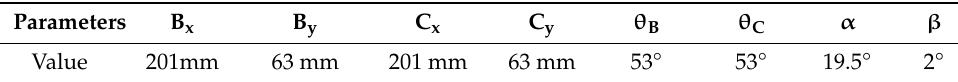
Figure 2. The simulated reflection number and spot distribution on mirror A, B and C. Table 1. The parameters used in the simulation in Figure 2.